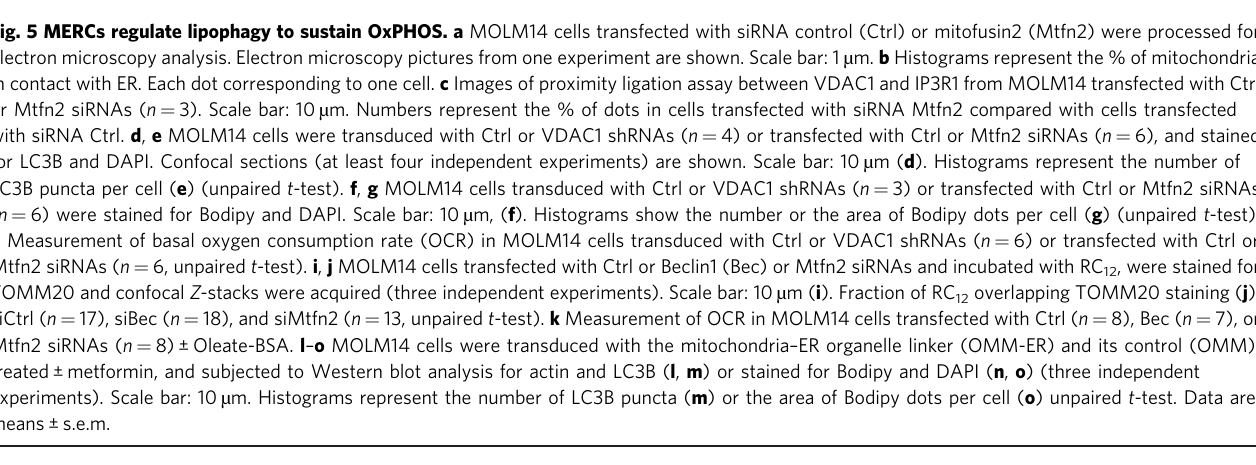
Fig. 5 MERCs regulate lipophagy to sustain OxPHOS. a MOLM14 cells transfected with siRNA control (Ctrl) or mitofusin2 (Mtfn2) were processed for electron microscopy analysis. Electron microscopy pictures from one experiment are shown. Scale bar: 1 µ m. b Histograms represent the % of mitochondria in contact with ER. Each dot corresponding to one cell. c Images of proximity ligation assay between VDAC1 and IP3R1 from MOLM14 transfected with Ctrl or Mtfn2 siRNAs ( n = 3). Scale bar: 10 µ m. Numbers represent the % of dots in cells transfected with siRNA Mtfn2 compared with cells transfected with siRNA Ctrl. d , e MOLM14 cells were transduced with Ctrl or VDAC1 shRNAs ( n = 4) or transfected with Ctrl or Mtfn2 siRNAs ( n = 6), and